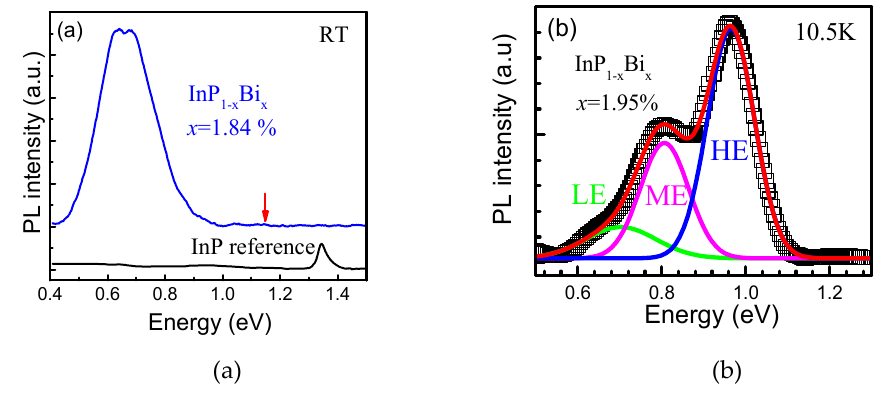
Figure 11. ( a ) Room temperature photoluminescence (PL) spectra of InPBi and InP. The red arrow is the band edge emission of InPBi bulk material. ( b ) PL spectrum of InPBi measured at 10.5 K. The frame line is the measured spectrum and the red solid line is the overall fitted spectrum while the green, pink and blue solid lines are fitted spectrum for low energy (LE), middle energy (ME) and high energy (HE), respectively.